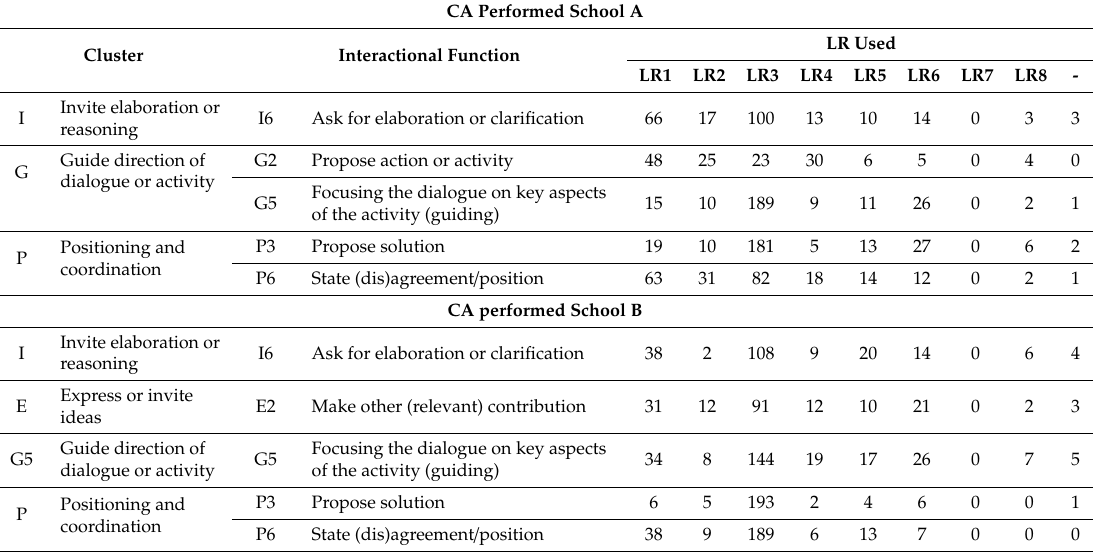
Table 6. LR used in the most frequently performed CA in each sociolinguistic area.